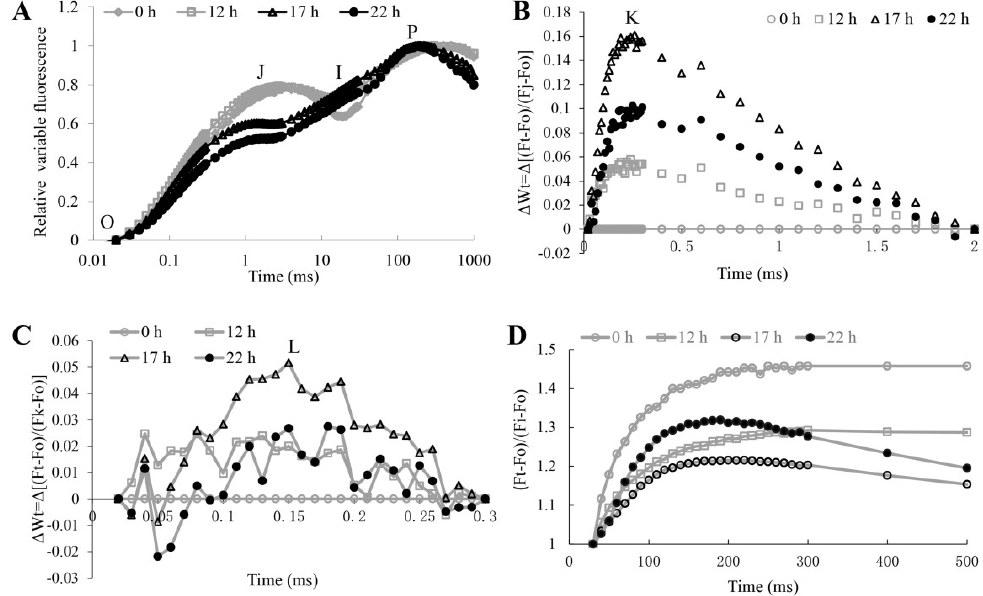
Figure 3. ( A ) During H. pluvialis non-motile cell germination, changes in chlorophyll a fluorescence transient (OJIP) are displayed on a logarithmic time scale (0 h, 12 h, 17h, and 22 h). Curves are expressed as relative variable fluorescence intensity (V t ), i.e., double normalized at the F O and F p points (V t = (F t − F O )/(F p − F O )). ( B , C ) ΔW t transient kinetics, i.e., the values double normalized at the F O and F J points ( B ) and the F O and F K points ( C ), during H. pluvialis non-motile cell germination (12 h, 17h,